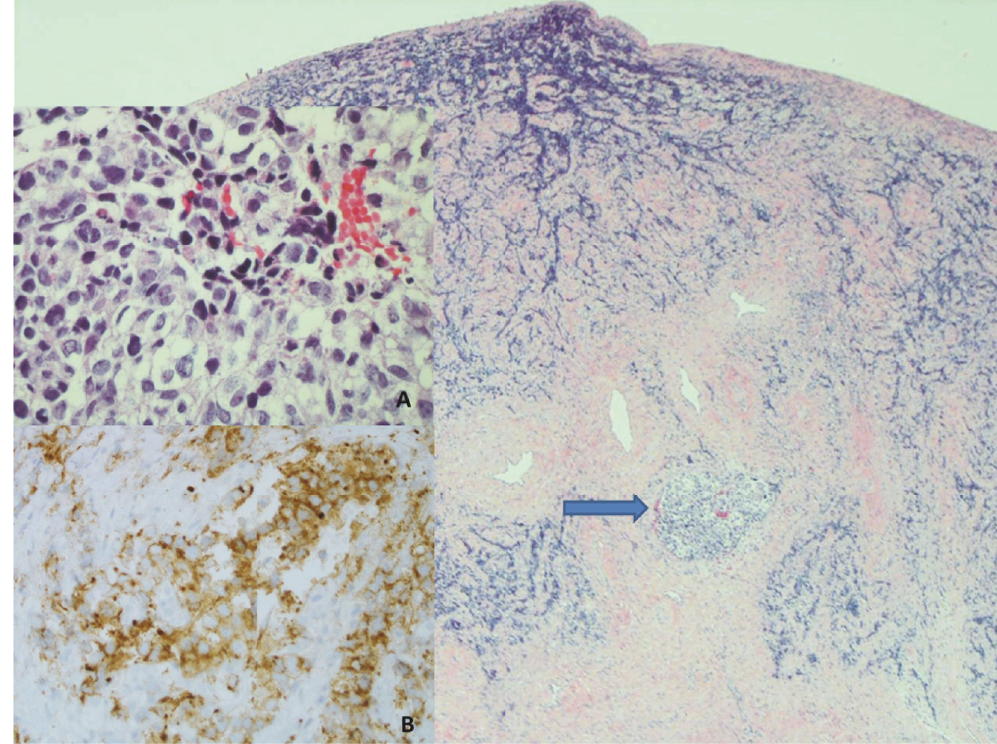
Figure 3: Cervical biopsy (40X): the infiltrative carcinoma is largely distorted by crush artifact. A preserved intravascularfocus of carcinoma (arrow and inset A, 500X) is characterizedby cells with variable clear to eosinophilic cytoplasm, round to oval nuclei,delicate chromatin,and punctatenucleoli.Scatteredapoptoticcellsarenoted.Thetumorcellsarestronglyimmunoreactiveforneuroendocrinemarkerssynaptophysin (inset B,